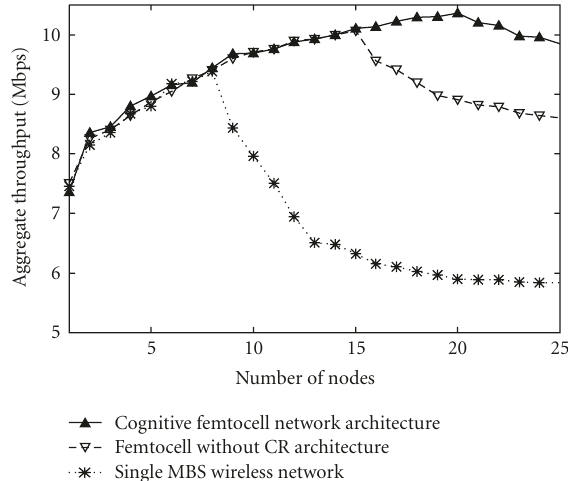
Figure 4: Convergence of the branch and bound method for the joint power control, base station assignment, and channel assignment scheme. The number of nodes is varied from 8,10 and 15 clients. The clients are randomly distributed in each of the 8- client, 10-client, and 15-client configurations except for 3 private clients.